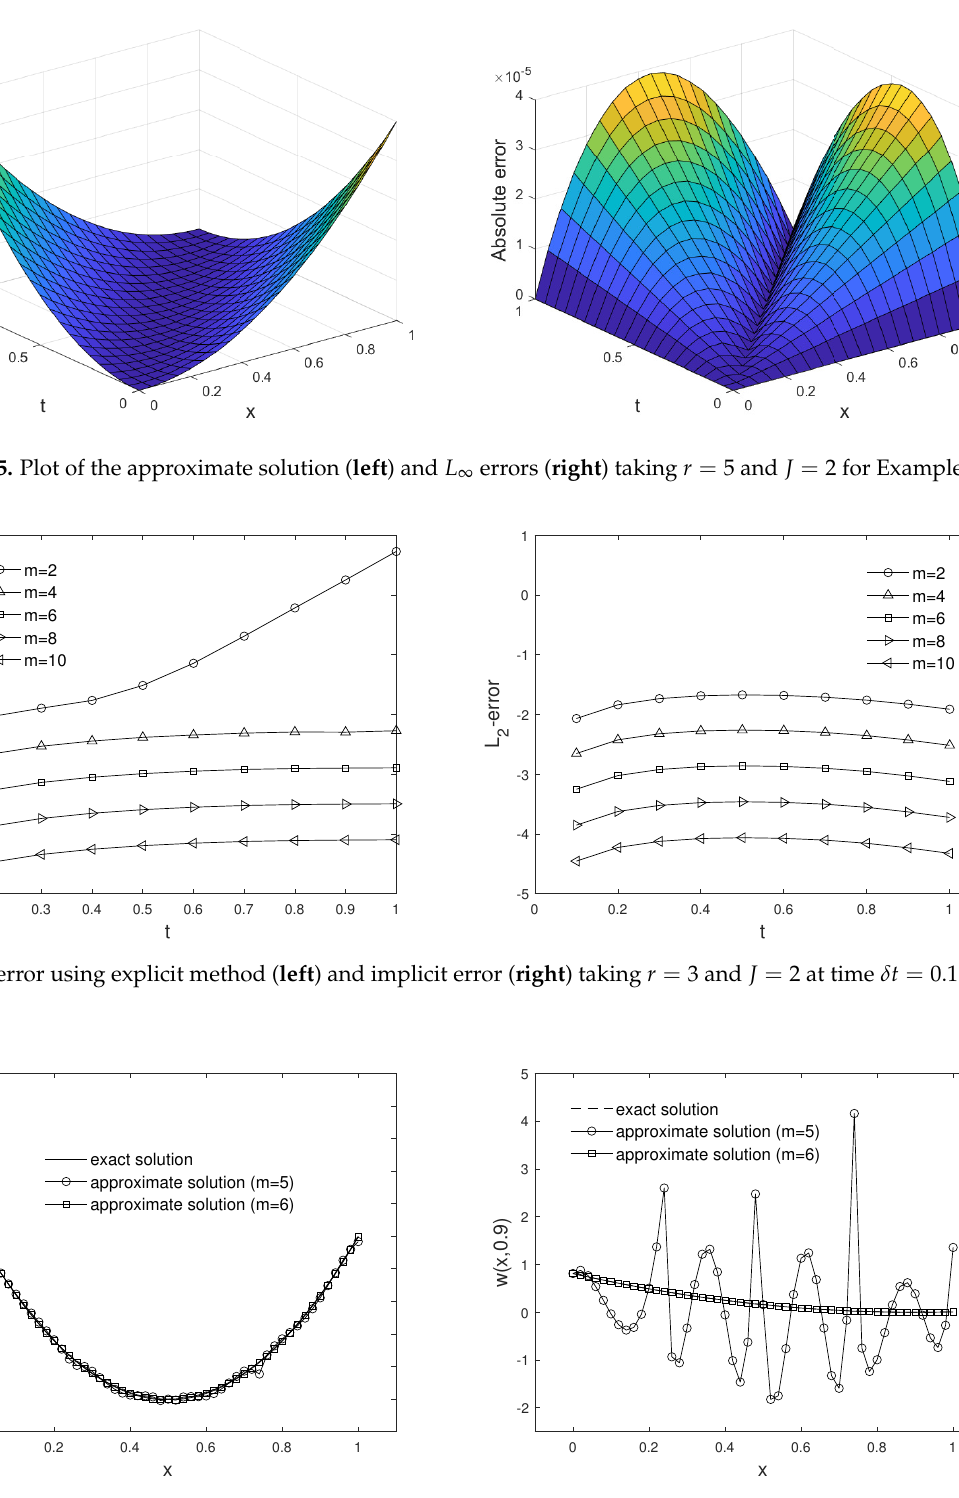
Figure 7. Plot of exact and approximate solutions at time t = 0.5 and t = 0.9 taking θ = 0, r = 5, J = 2 and δ t = ( 0.1 ) /2 m for Example